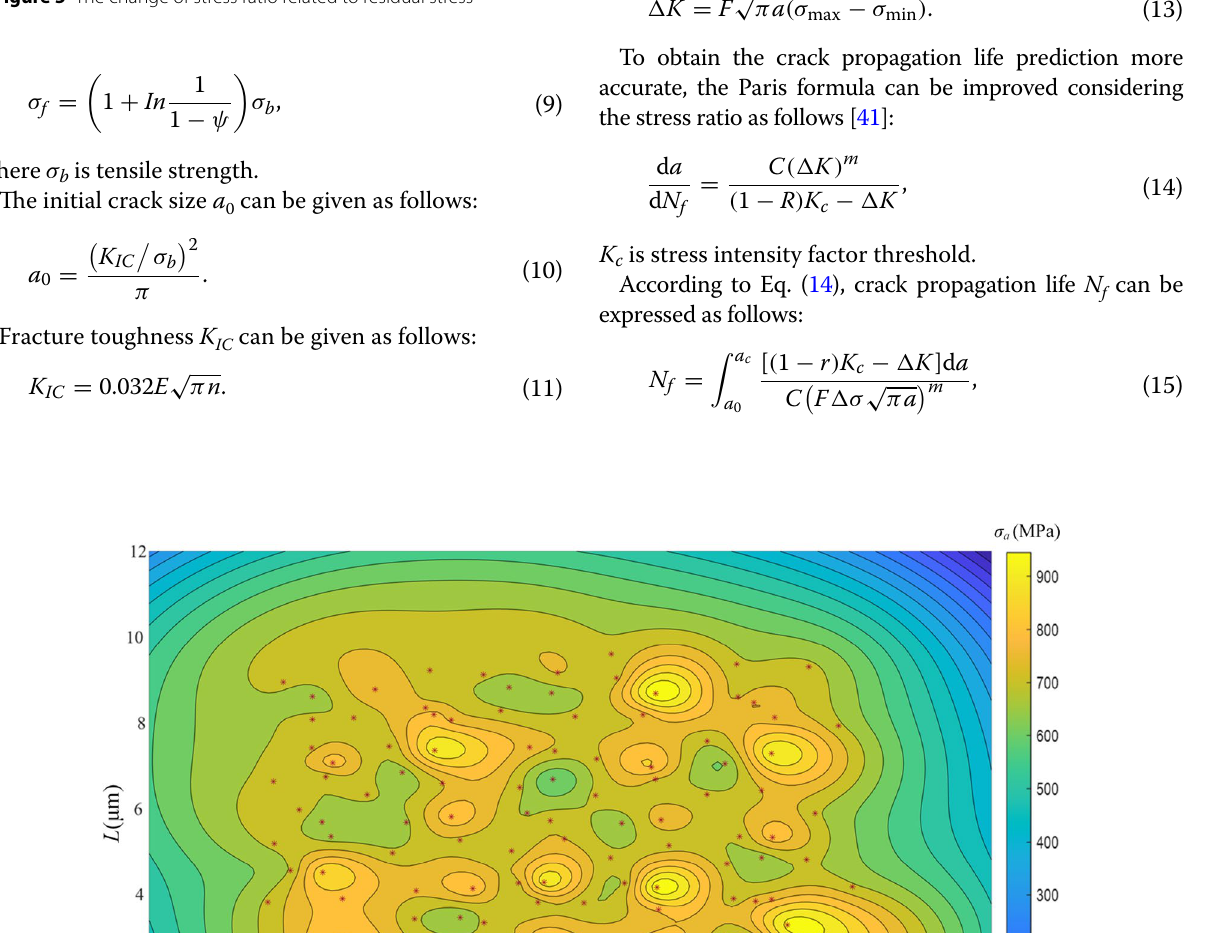
Figure 5 The change of stress ratio related to residual stress